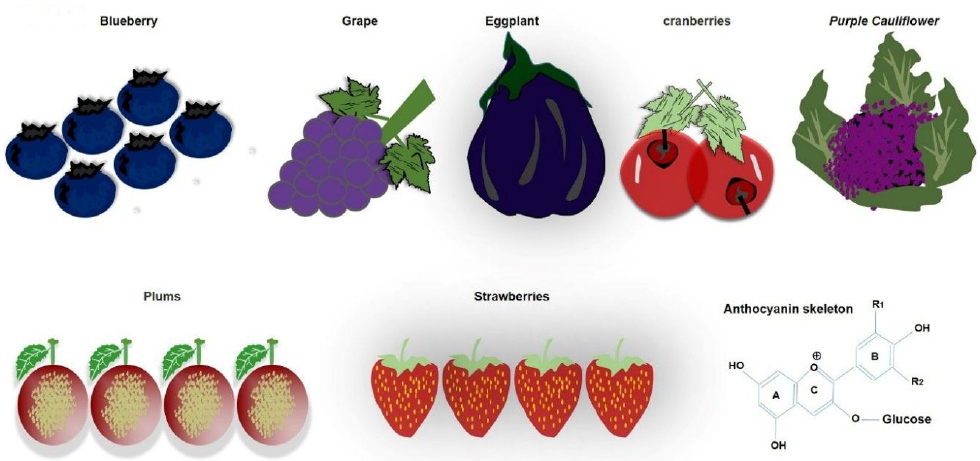
Figure 3. Natural dietary Anthocyanin sources. Various fruits and vegetables are rich sources of natural dietary anthocyanin.